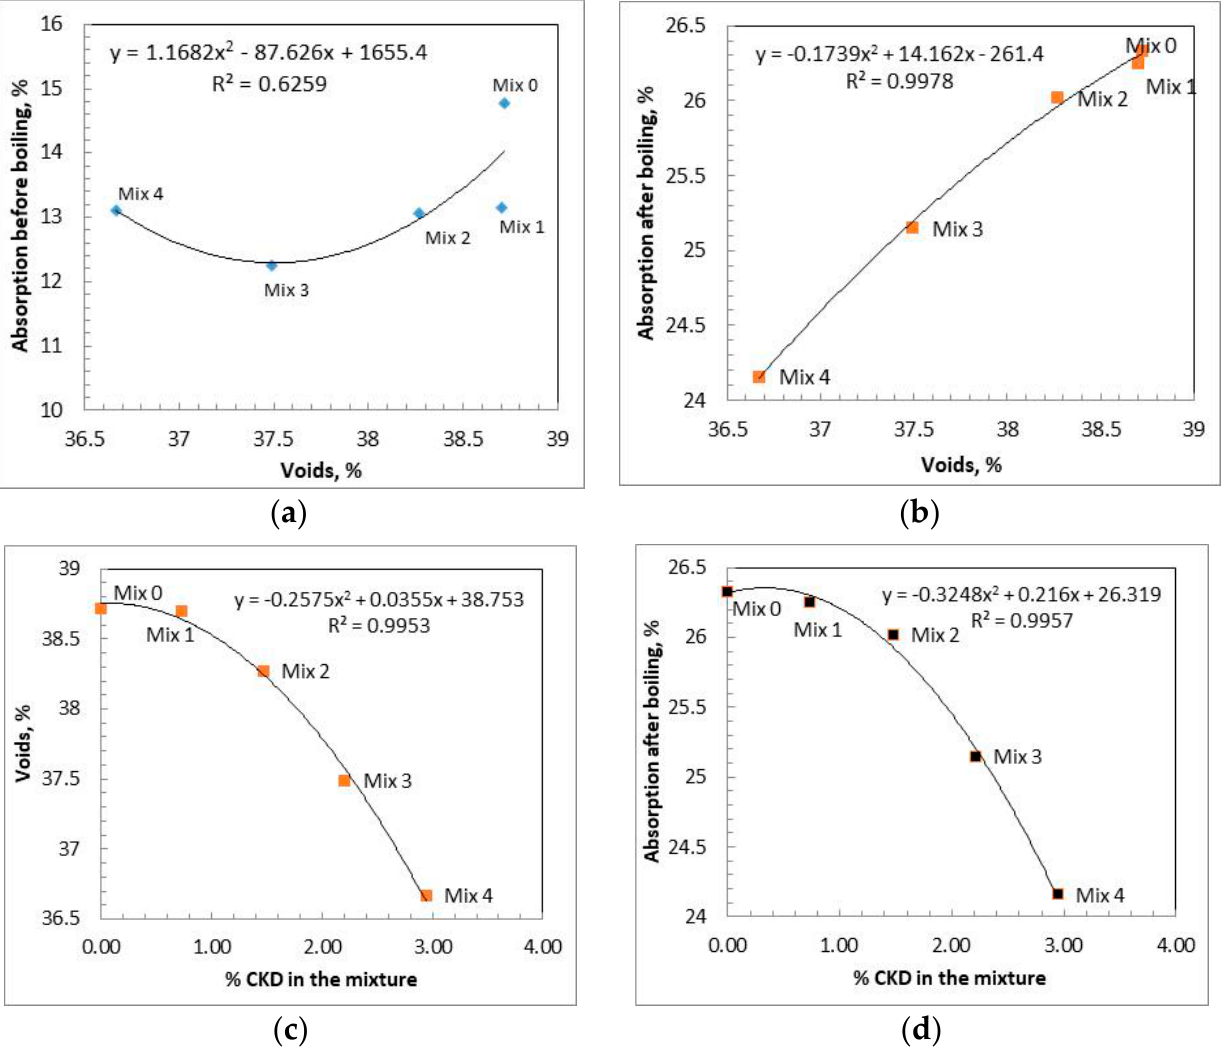
Figure 7. ( a ) Cold absorption versus voids, ( b ) hot absorption versus voids, ( c ) voids versus CKD % in the whole mixture, and ( d ) voids versus CKD % in the whole mixture. Figure 8 is a pictorial form generated from the data presented in Table 9;